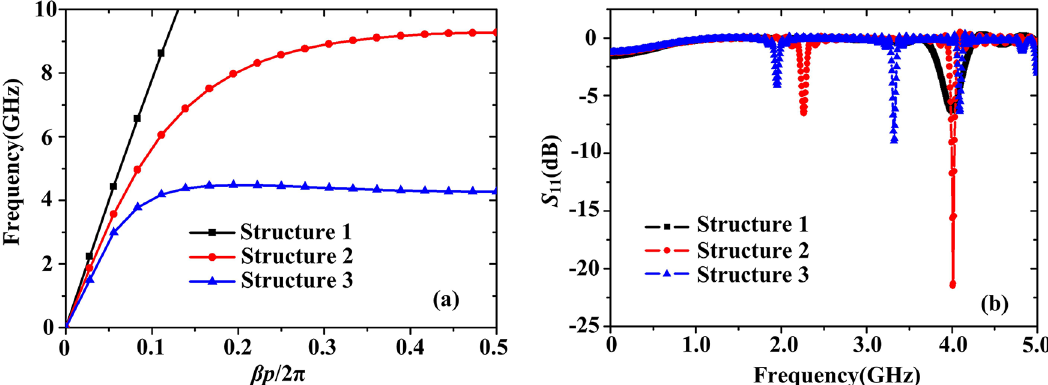
Fig. 3. (a) Dispersion curves and (b) simulated re fl ection coef fi cients of Structures 1 – 3.